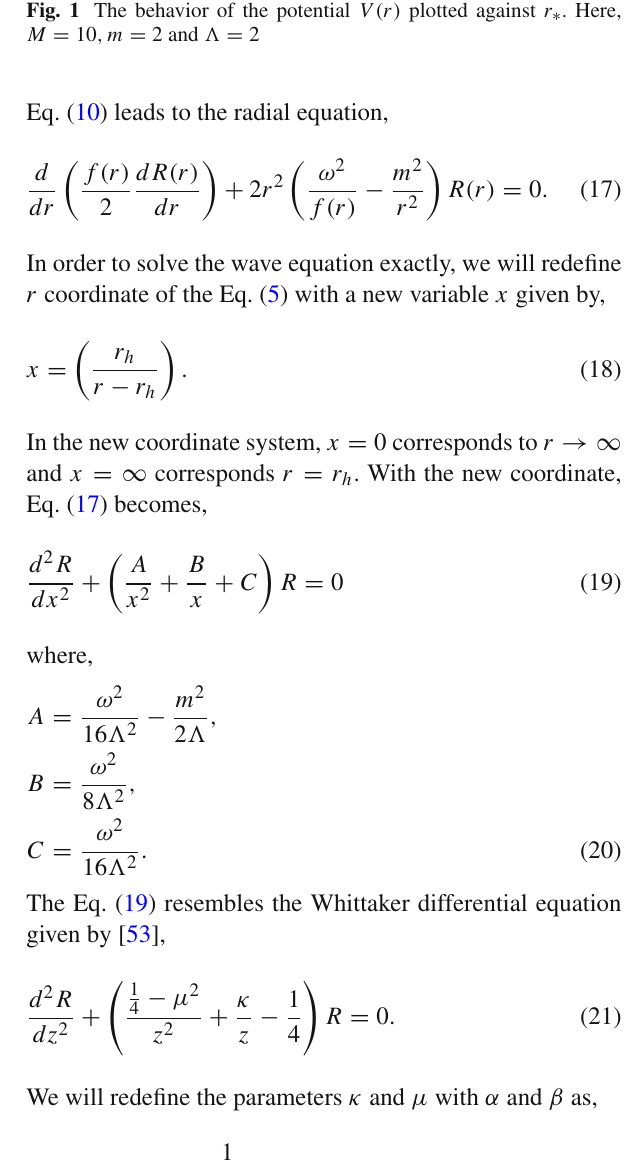
Fig. 1 The behavior of the potential V ( r ) plotted against r ∗ .